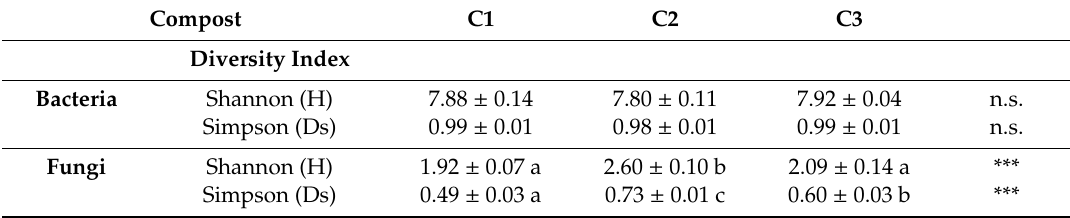
Table 3. The Shannon and Simpson diversity index for compost bacteria and fungi.